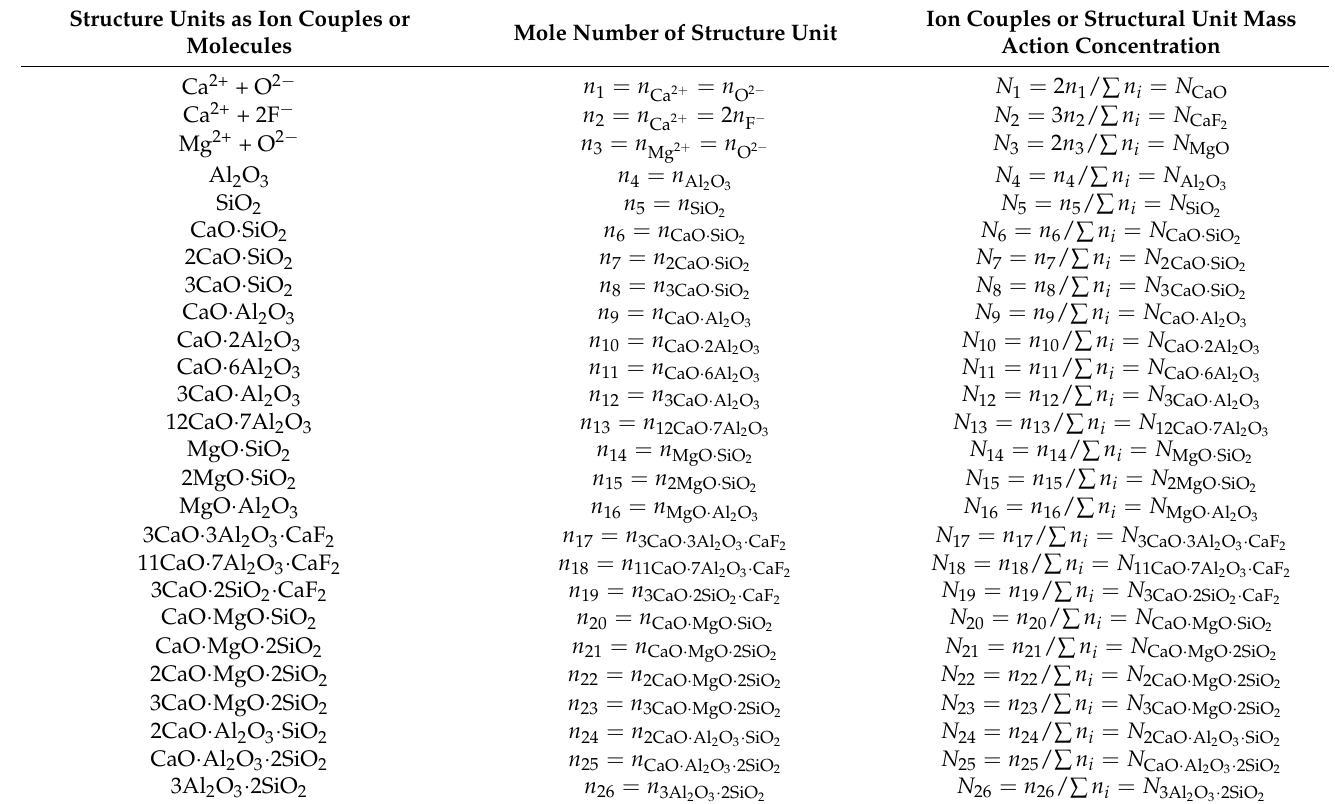
Table 7. CaO-MgO-SiO 2 -Al 2 O 3 -CaF 2 slags based on IMCT: expression of structural units as ion couplings or complex molecules, their mole numbers, and mass action concentrations. Ion Couples or Structural Unit Mass Structure Units as Ion Couples or Mole Number of Structure Unit Molecules